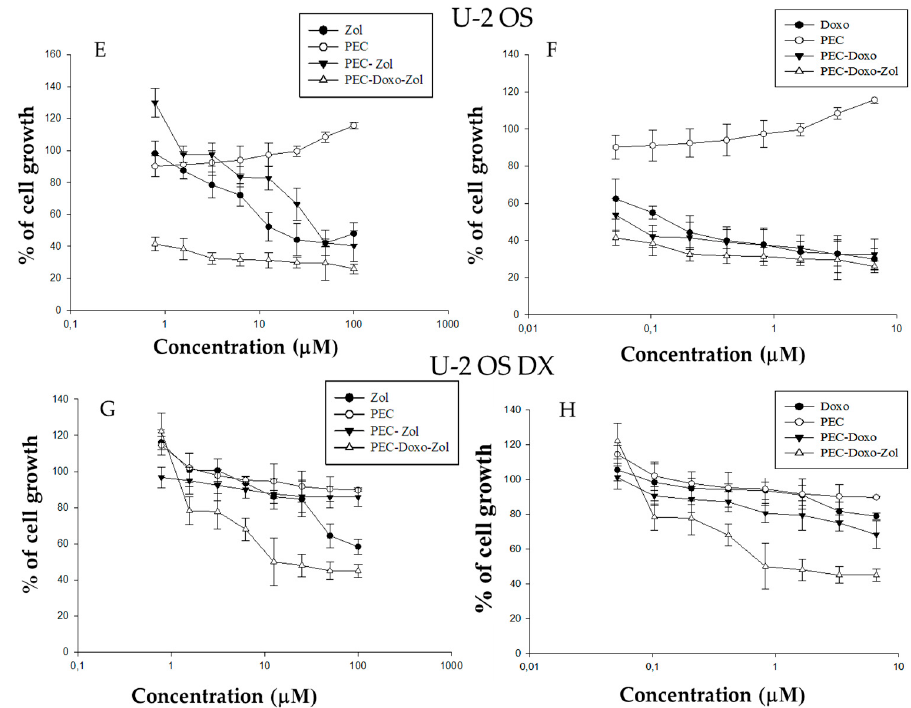
Figure 2. Dose–effect relationship of all developed formulations on wild-type and Doxo-resistant wild-type human osteosarcoma cells (SAOS) and wild-type human bone osteosarcoma epithelial cells (U-2 OS) proliferation. Results are expressed as % of cell growth vs. concentration ( µ M) of Zol ( A , C , E , and G ) or Doxo ( B , D , F , and H ). In the case of cells treated with unloaded PECs, the PEC concentration was adjusted as equivalent to the concentration of drug-loaded PECs.